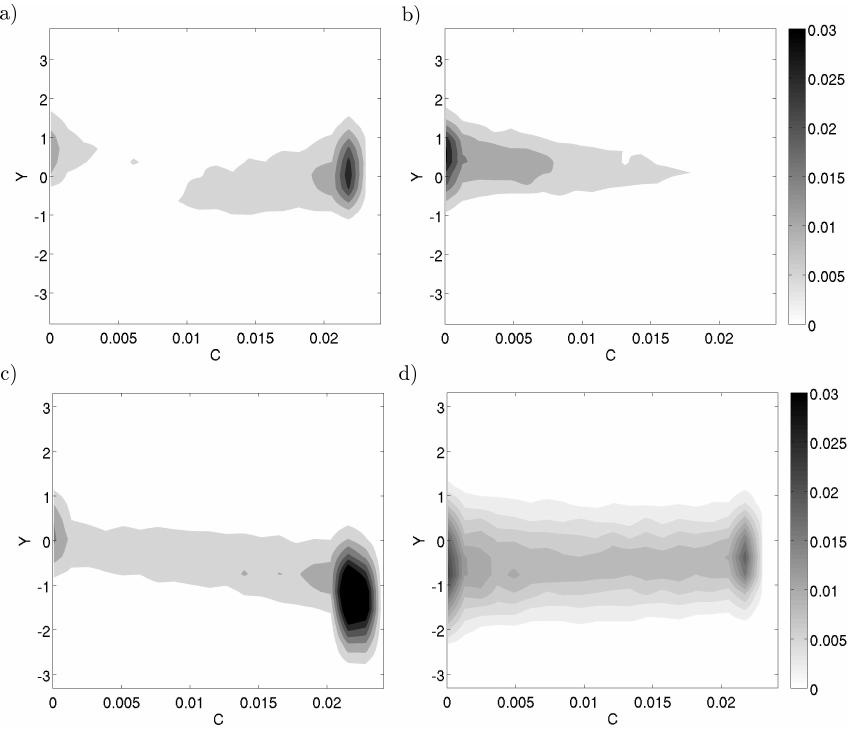
Fig. 4. Scenario 1: empirical bivariate pdf of concentration and log-transformed hydraulic conductivity computed in the vertical line at the expected x value of the plume centroid for (a) the EnKF at time 1 T , (b) the EnKF at time 4 T , (c) ES at time 1 T , and (d) ES at time 4 T . (computational time for the ES in these simulations is about 1/10 of the time required by the